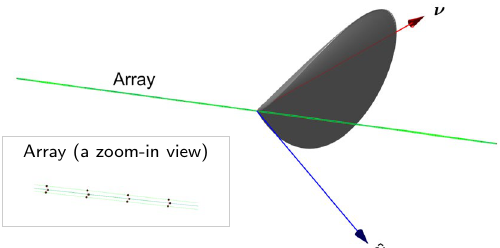
Fig. 3 The beampattern of the designed optimal beamspace beamformer is suppressed in the ambiguous